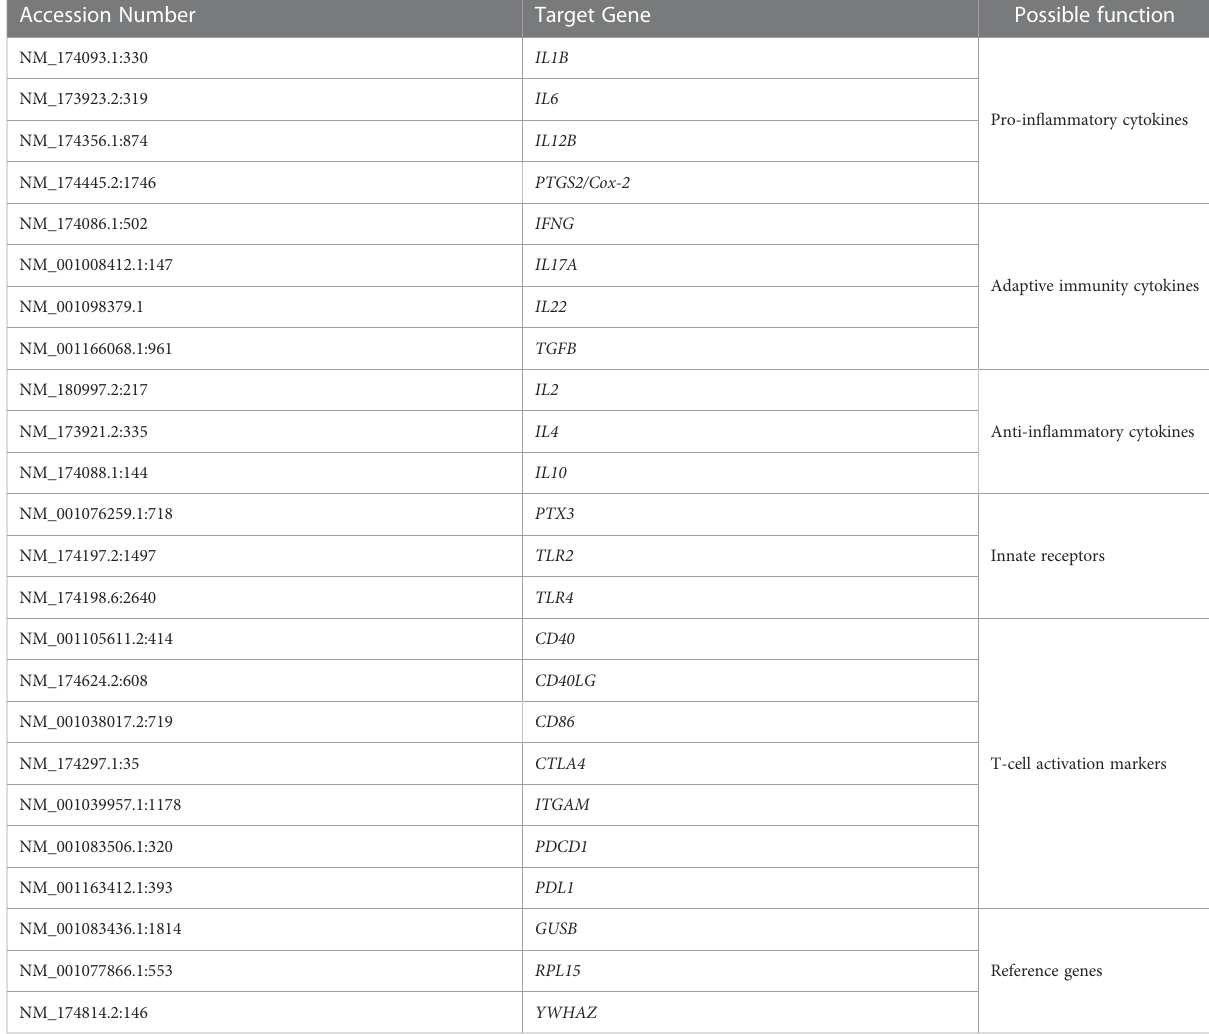
TABLE 3 List of genes analyzed by